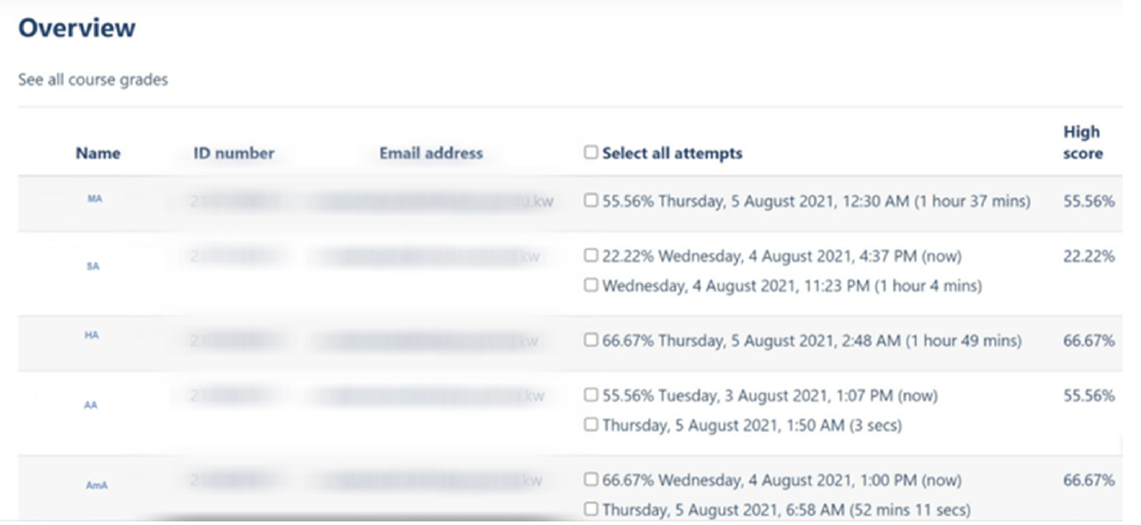
Figure 6. Screenshot of the a tt empt report of students. The student’s IDs and mail addresses are not disclosed to protect their privacy.